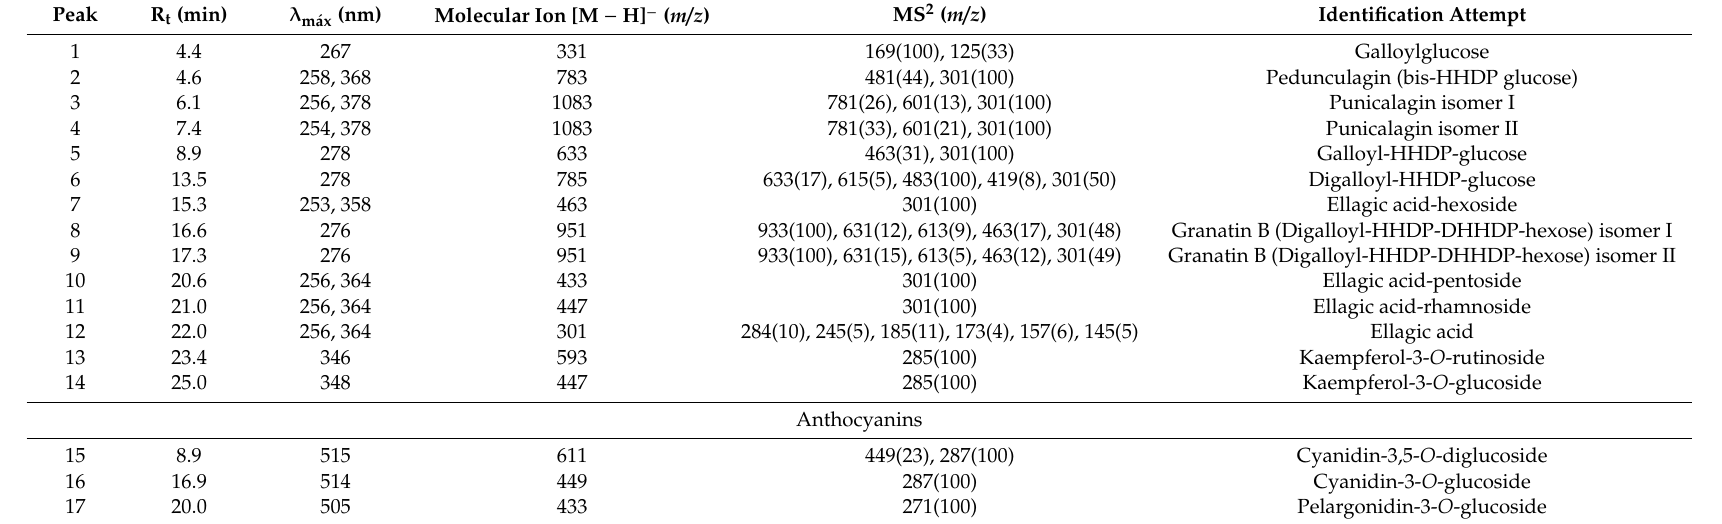
Table 1. Retention time (Rt), wavelengths of maximum absorption ( λ max ), mass spectral data and attempt to identify the phenolic compounds.